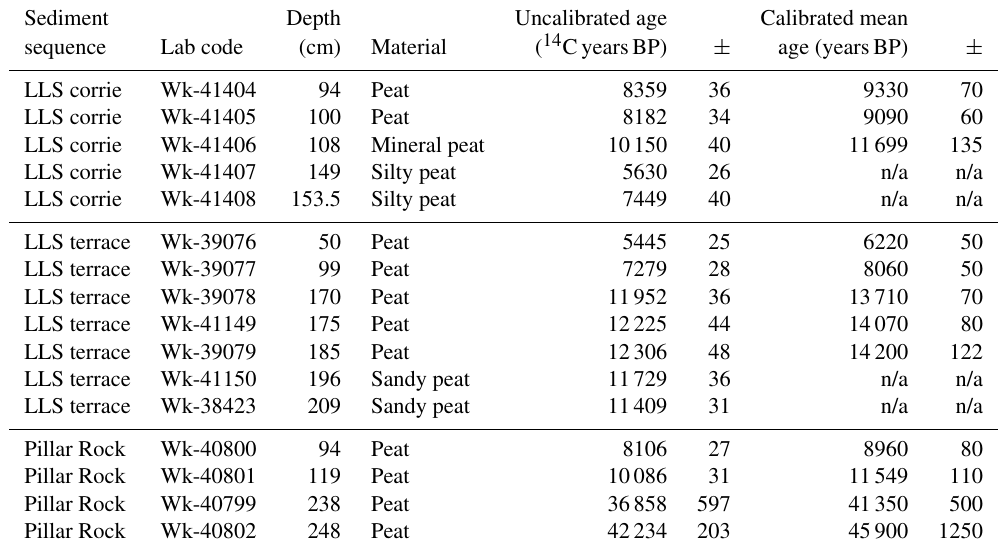
Table 2. Radiocarbon dating for sedimentary sequences taken from Pillar Rock, Musgrave Harbour, and lower “Lake” Speight cirque and